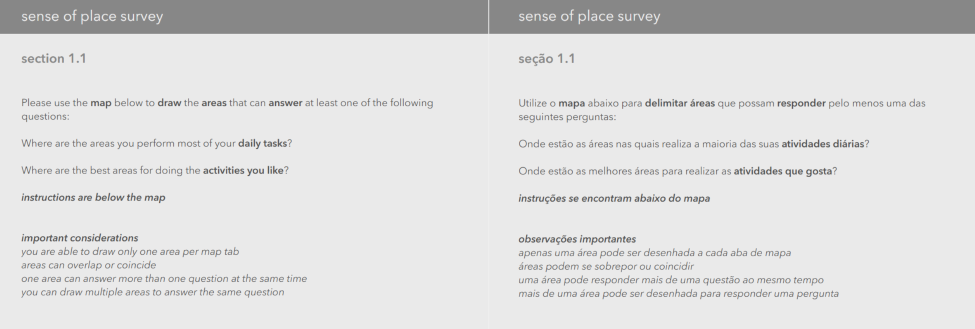
JOSIS, Number 23 (2021), pp.